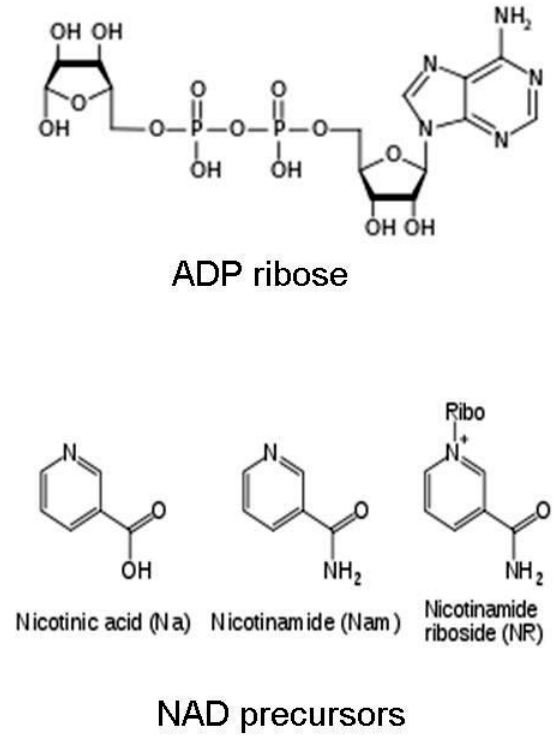
Figure 2. Chemical structures of nicotinic acid, nicotinamide, nicotinamide riboside, and ADP ribose.